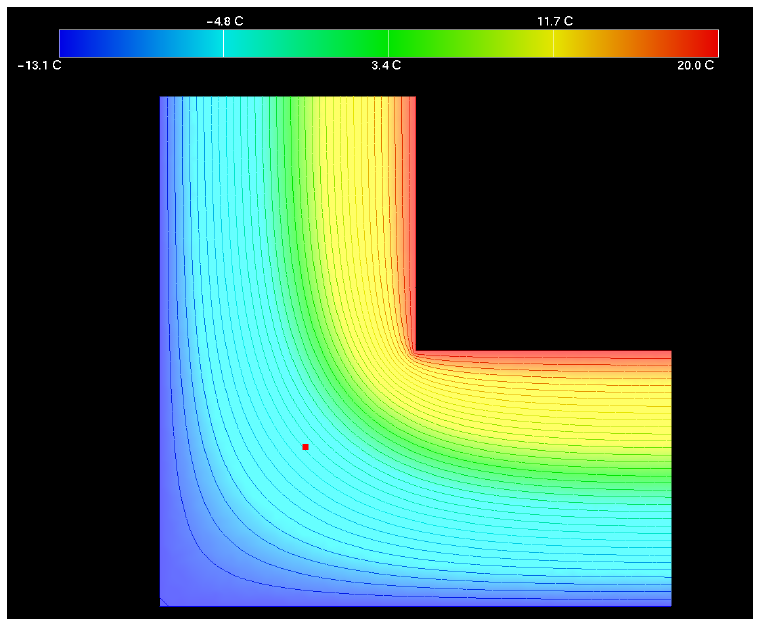
Figure 1. A two-dimensional solution on an interior edge, the point ( 0.25,0.25 ) marked with a red